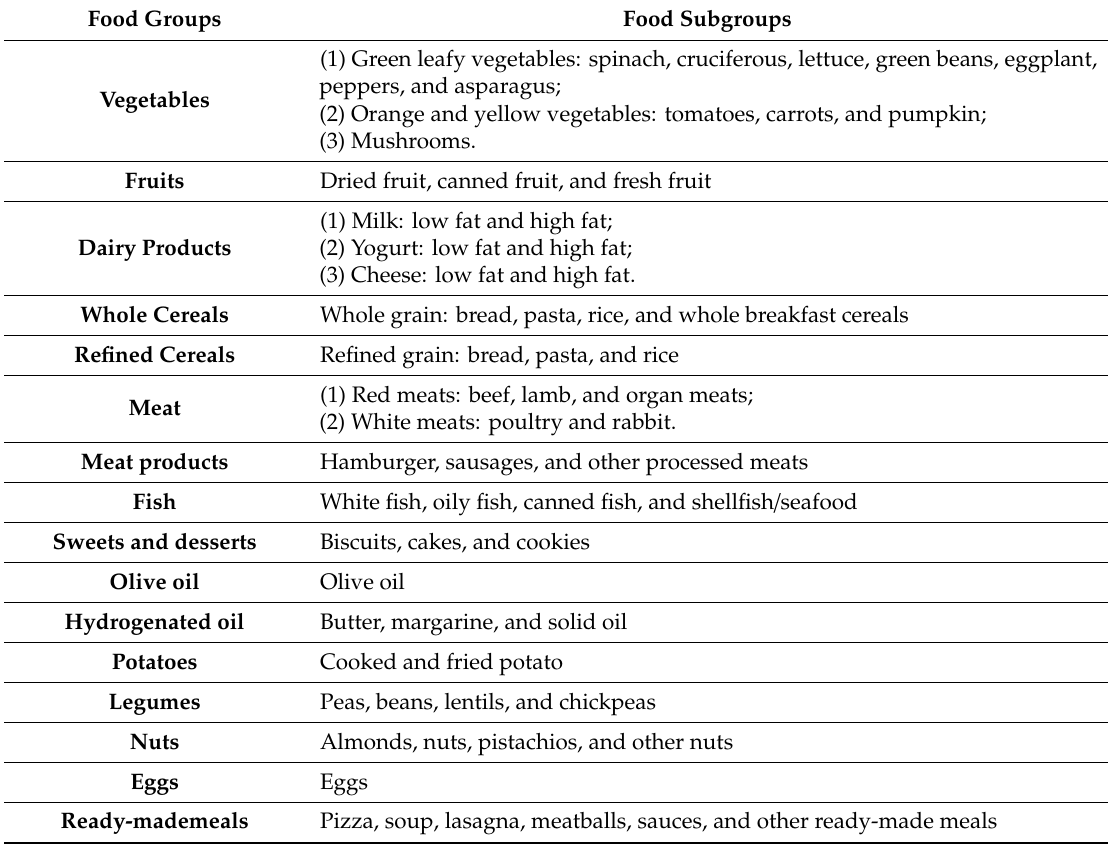
Table 1. Food groupings used in factor